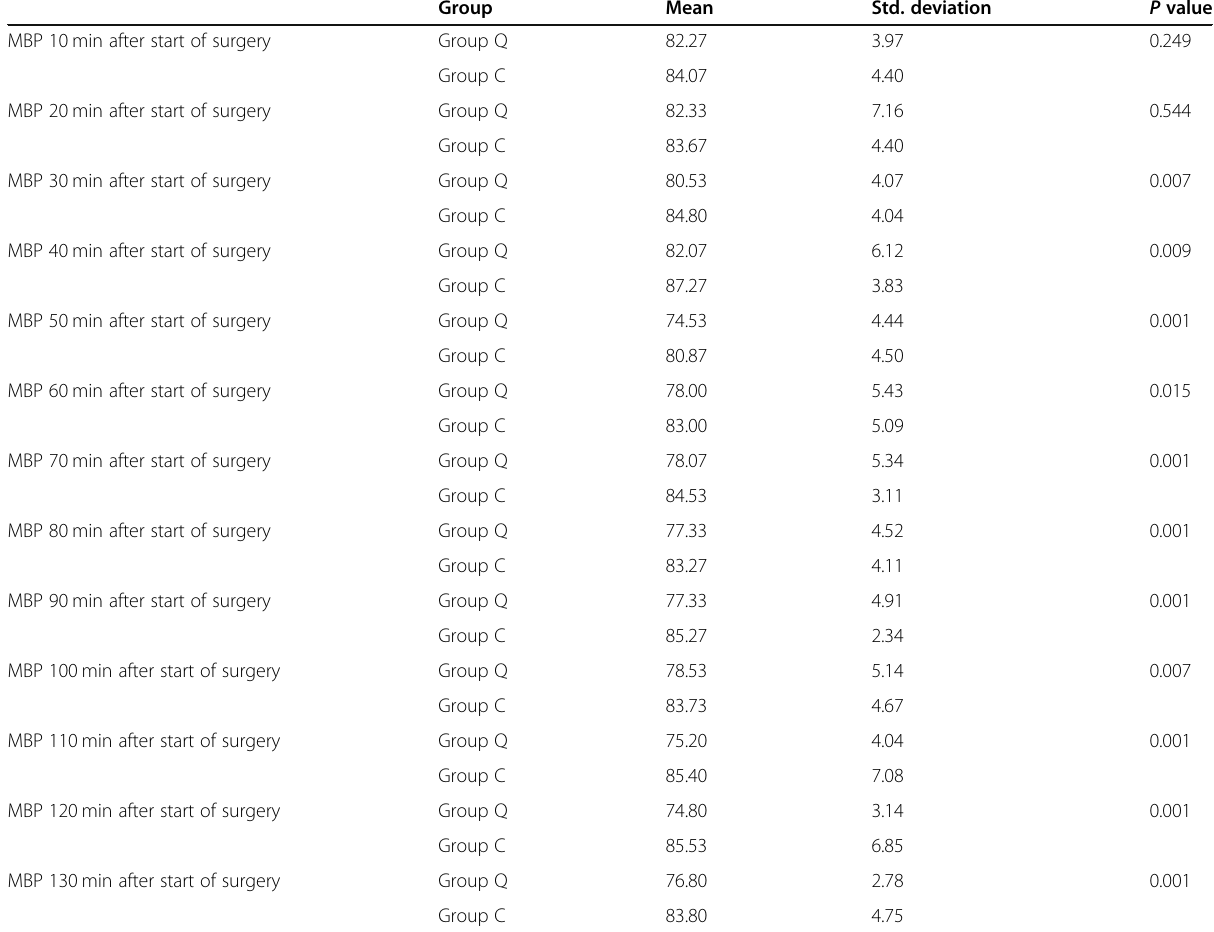
Table 3 Comparison between the QLB (Q) group and the control (C) group regarding blood pressure